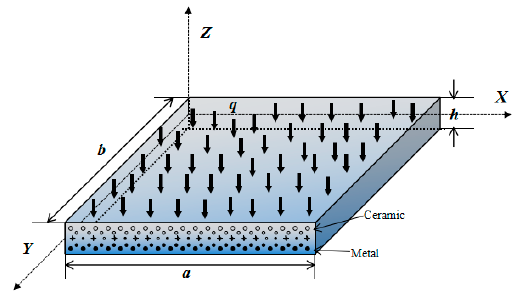
Figure 1. Geometry of the functionally gradient material (FGM) plate.